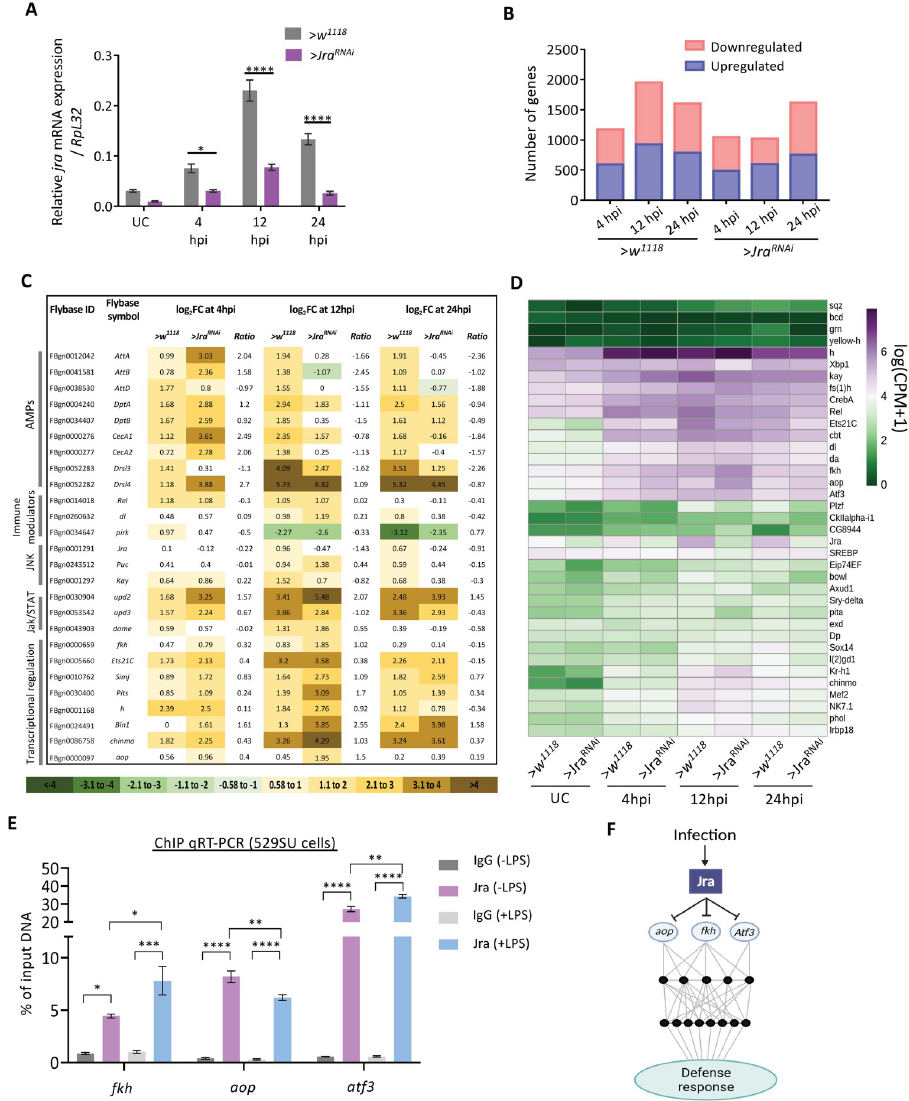
Fig 3. Jra is a major regulator of the Pe infected gut transcriptome. A. Kinetics of activation of Jra transcripts, as measured by qRT-PCR in > w 1118 and > Jra RNAi without and with gut infection. � p = 0.0144, ���� p < 0.0001 as determined by 2-way ANOVA with Bonferroni’s post-hoc test for multiple comparisons. Data from three independent experiments. Means and SEMs represented. B. Bar plot representation of a total number of significantly differentially expressed genes (FDR < 0.1) obtained by comparing > w 1118 and > Jra RNAi under UC conditions post a 3’ mRNA sequencing experiment. C. Tabular representation of log 2 FC values of transcripts for a few categories of defence genes regulated during the infection. Log 2 FC values in the range 0.58 to -0.58, indicating no significant changes compared to UC, are marked in white. The log 2 FC ratios for each experimental condition are also shown. D. Jra binds to the promoters of several genes (data plotted from modERN dataset ENCSR471GSA). Heatmap represents the normalised expression counts of genes for TFs, enriched in the RNA-seq data set, with Jra binding peaks on the promoters. E . Binding of Jra to the promoters of fkh , aop and atf3 with and without LPS induction in 529SU cells, as quantitated by RT-PCR post a Jra specific Chromatin Immunoprecipitation (ChIP) assay. F. Schematic of Jra immune regulatory network representing the effect of Jra on a subset of TFs. ChIP-PCR data and RNA-seq data taken together confirms the repression of fkh , aop and atf3 by Jra in regulating the immune response.